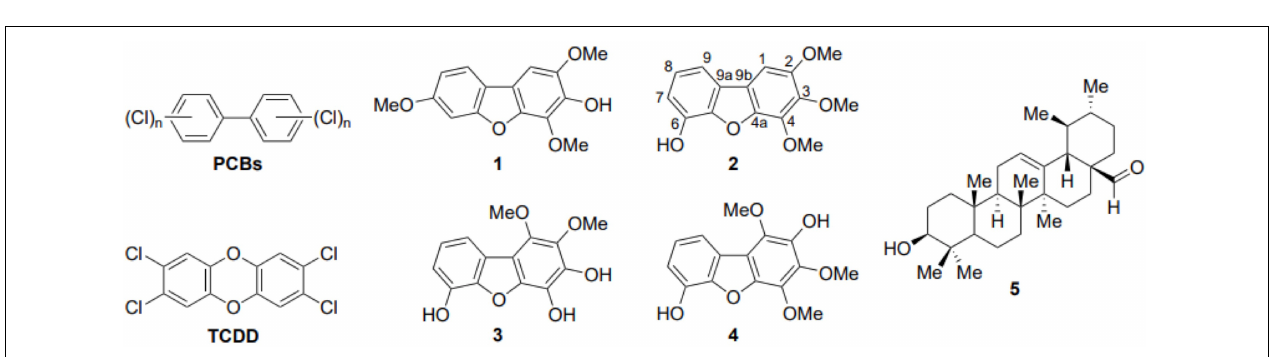
FIGURE 2 | Effects of isolated compounds from the dibenzofuran family on melanin synthesis in zebrafish. (A) Embryos were treated from 24 to 48 hpf with 0.01 mg/mL of the compounds and the effects on the pigmentation were assessed using a stereomicroscope. (B) Melanin content was quantified by a photometric method. PTU was used as positive control. Results shown are the mean of three independent experiments ± SEM. ∗ p < 0.001, versus DMSO control.